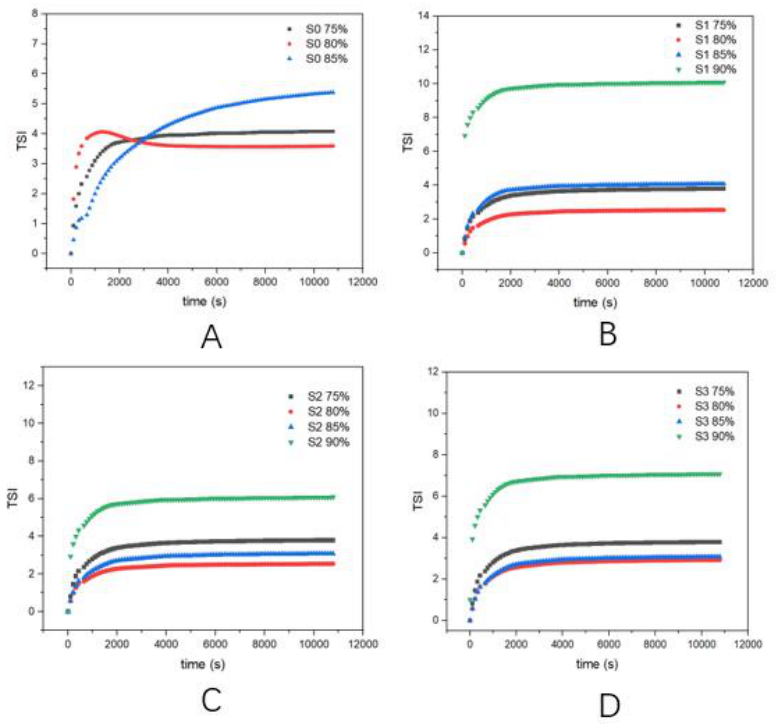
Figure 6. TSI (Turbiscan stability index) of groups under different oil phase concentrations (75%, 80%, 85%, 90%) as a function of time (25 °C). ( A : S0, B : S1, C : S2, D : S3).